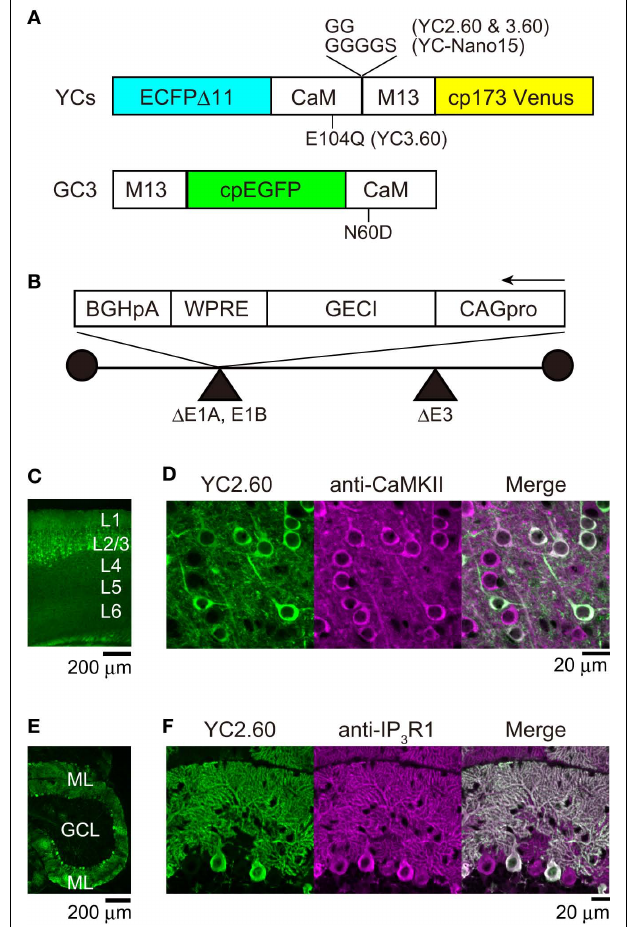
FIGURE 1 |Adenovirus-mediated expression of GECIs. (A) The domain structure of GECIs. ECFP Δ C11, enhanced CFP with C-terminal 11 amino acids deleted; CaM, calmodulin; M13, Ca 2 + /CaM-binding peptide from skeletal muscle myosin light chain kinase; cp173Venus, circularly permuted Venus; cpEGFP, circularly permutated enhanced green fluorescent protein. (B) The structure of recombinant adenovirus vector for expression of GECIs. CAG pro, cytomegalovirus enhancer and β -actin promoter;WPRE, woodchuck hepatitis virus post-transcriptional regulatory element; BGHpA, bovine growth hormone polyadenylation signal. (C) Confocal image of a parasagittal section from an E14:P20YC2.60 mouse. Each cortical layer (L) position is indicated in white. (D) Confocal image of the neocortex immunostained with anti-CaMKII antibody, a marker for excitatory pyramidal cells. (E) Confocal image of a parasagittal section from an E11:P21YC2.60 mouse. ML, molecular layer; GCL, granule cell layer. (F) Confocal image of the cerebellum immunostained with anti-IP 3 R1 antibody, a marker for Purkinje cells.